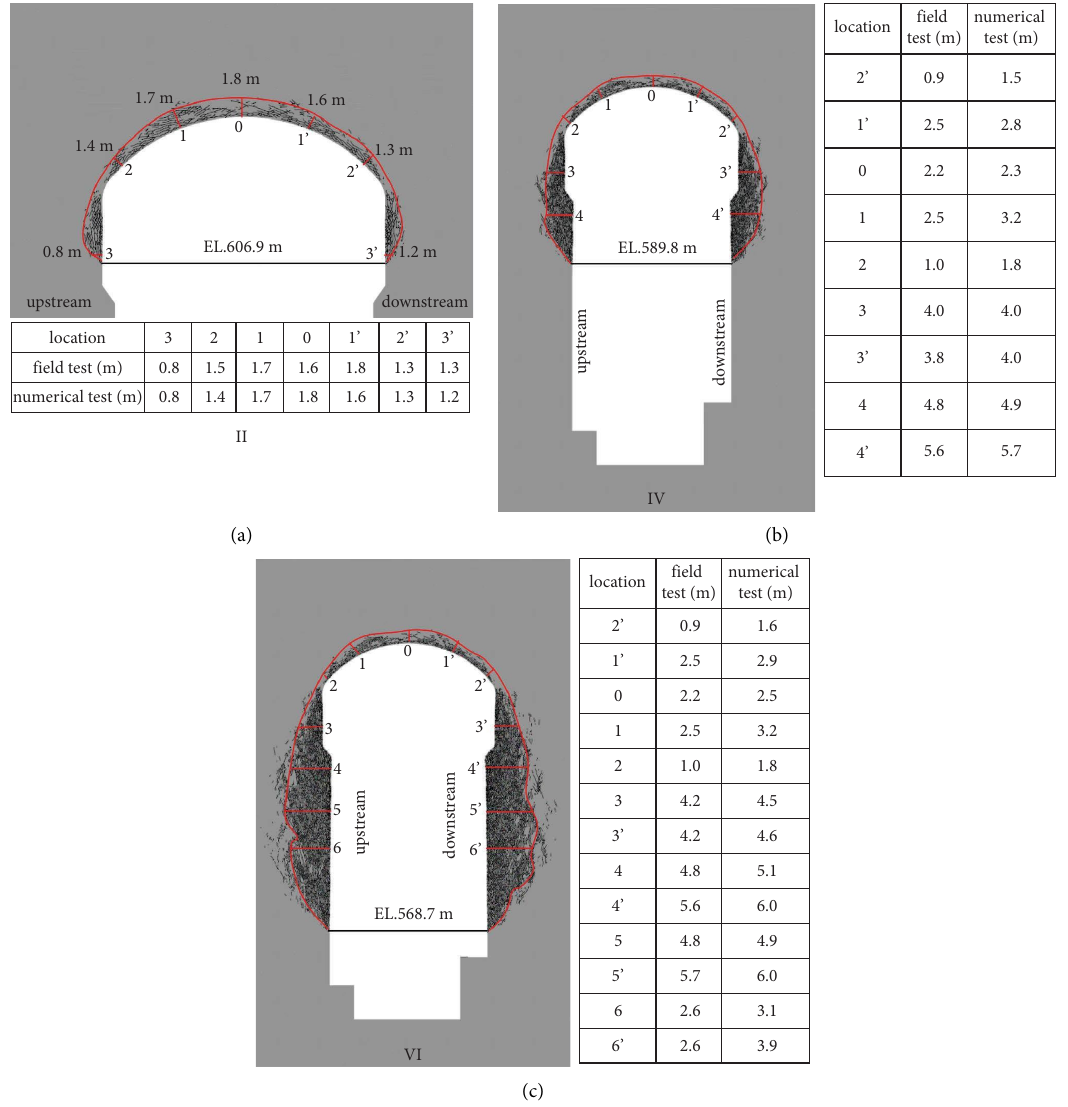
Figure 6: Feedback results of the relaxation depth after the excavation of (a) layer II, (b) layer IV, and (c) layer VI.